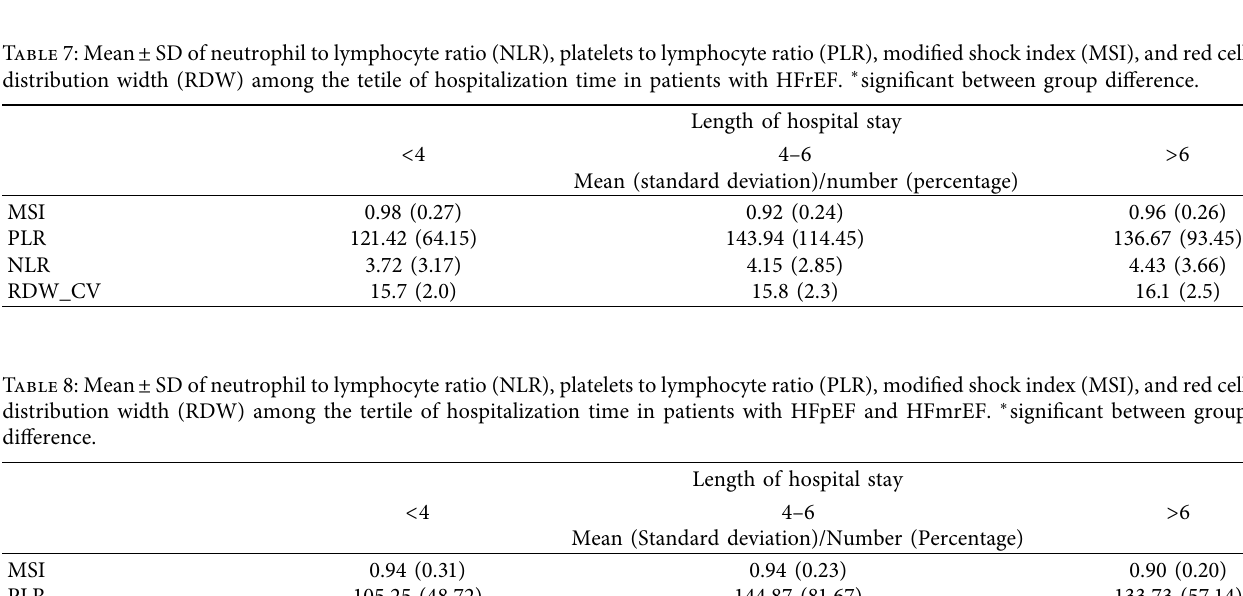
Bold values indicate values with signifcant diferences among tertiles of length of hospital